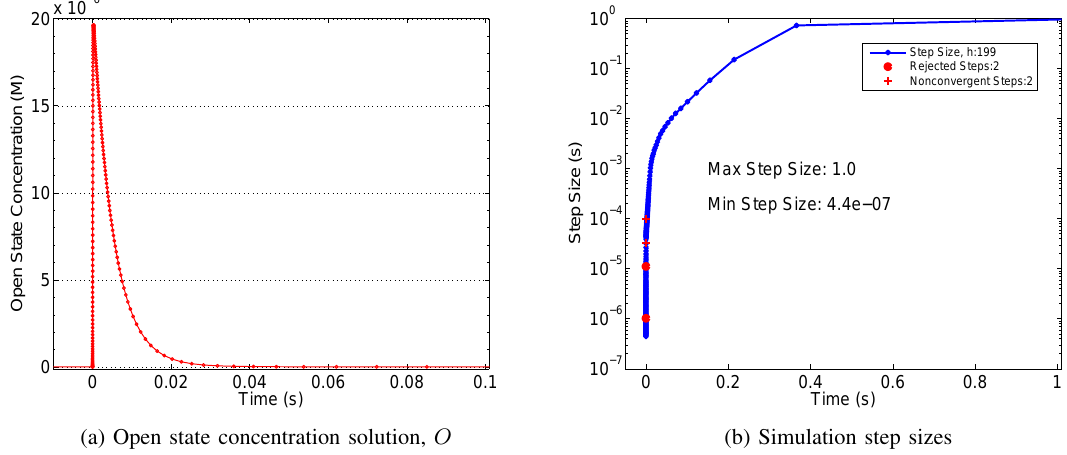
Fig. 8: Radau method solution of the AMPAR model. TABLE III: Simulation time steps results for the ERK and IRK methods when solving the AMPAR